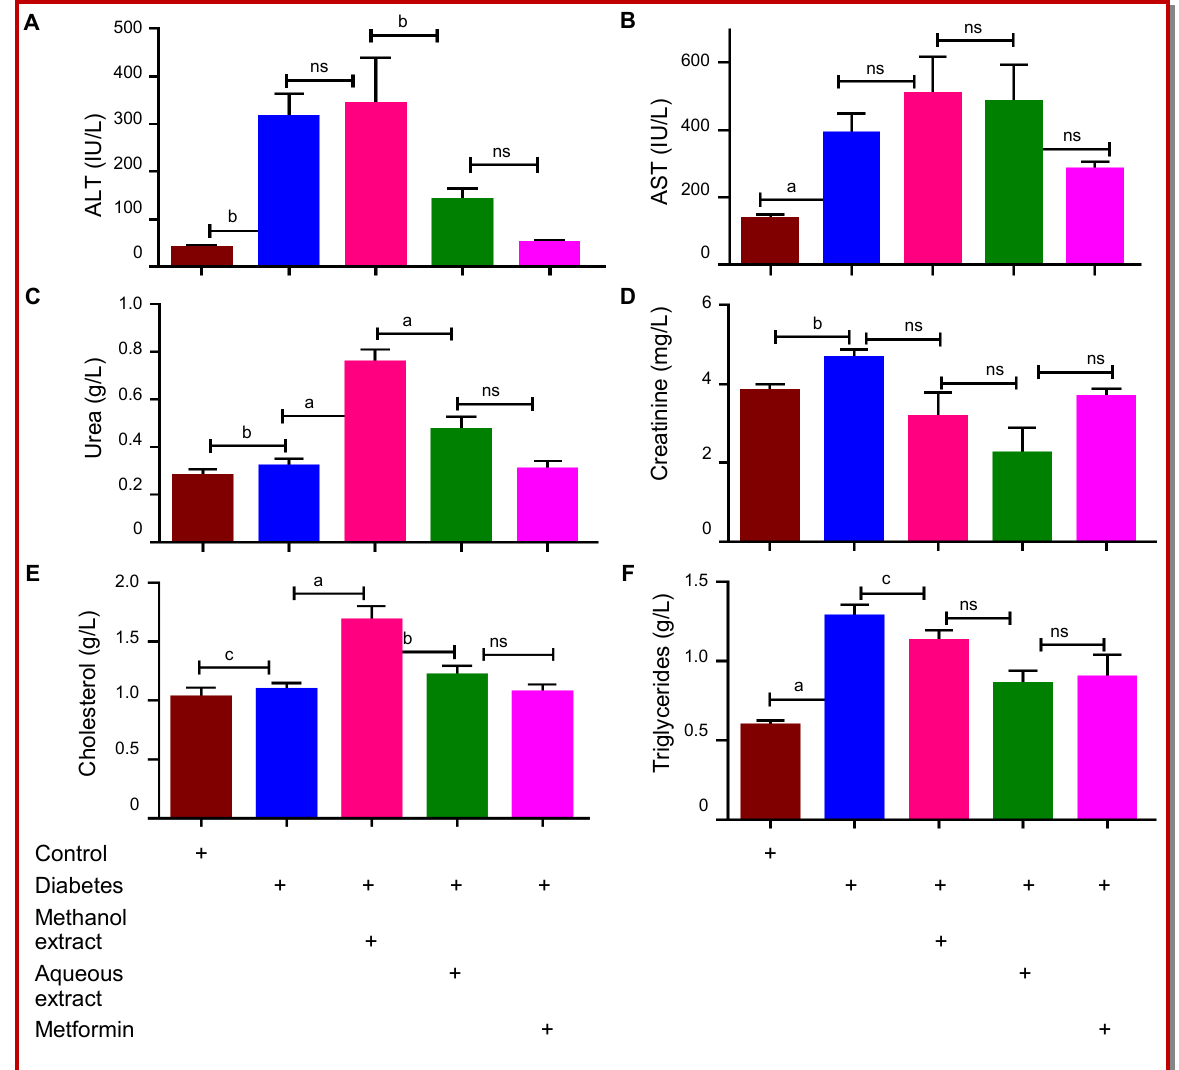
Figure 2: Variation in alanine transaminase (ALT)(A), aspartate transaminase (AST)(B), urea (C), creatinine (D), cholesterol (E) and triglycerides (F) levels in the blood of different groups of mice ns: Difference not statistically significant; Statistically very significant differences a p<0.001; Difference moderately statistically significant b p<0.01; Statistically significant differences c p<0.05 concentration in diabetic mice dropped significantly in diabetic mice treated with macerates of A. gummifera and metformin. Indeed, the creatinine level became 2.3 ± 0.6 mg/L after treatment of diabetic mice by aqueous macerate, and 3.2 ± 0.6 mg/L after treatment with macerated methanol, and 3.7 ± 0.2 mg/L after treatment with metformin with differences statistically insigni- ficant between these last three groups and significant compared to the tested mice, non-diabetic mice and untreated diabetic mice (Figure 2). Cholesterol and triglycerides The cholesterol and triglyceride levels in non-diabetic mice were 1.0 ± 0.2 and 0.6 ± 0.0 g/L respectively. While